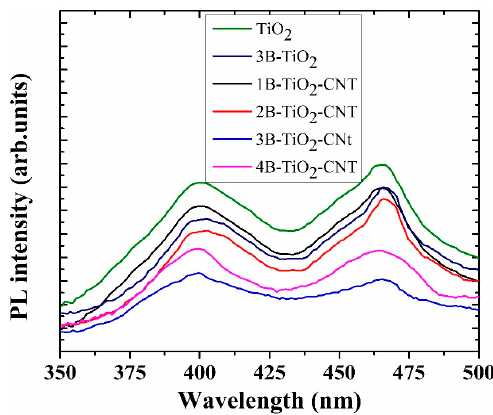
Figure 3. PL spectra of TiO 2 , 3B-TiO 2 and B-TiO 2 -CNT nanocomposites.